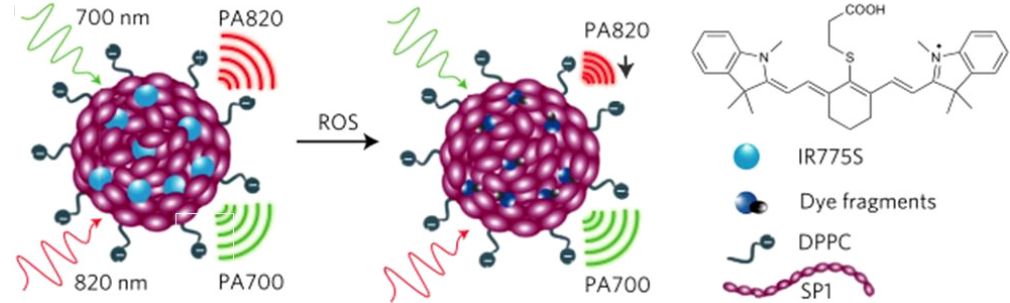
Fig. 7. In vitro characterization of RSPN for ROS sensing. Proposed ROS sensing